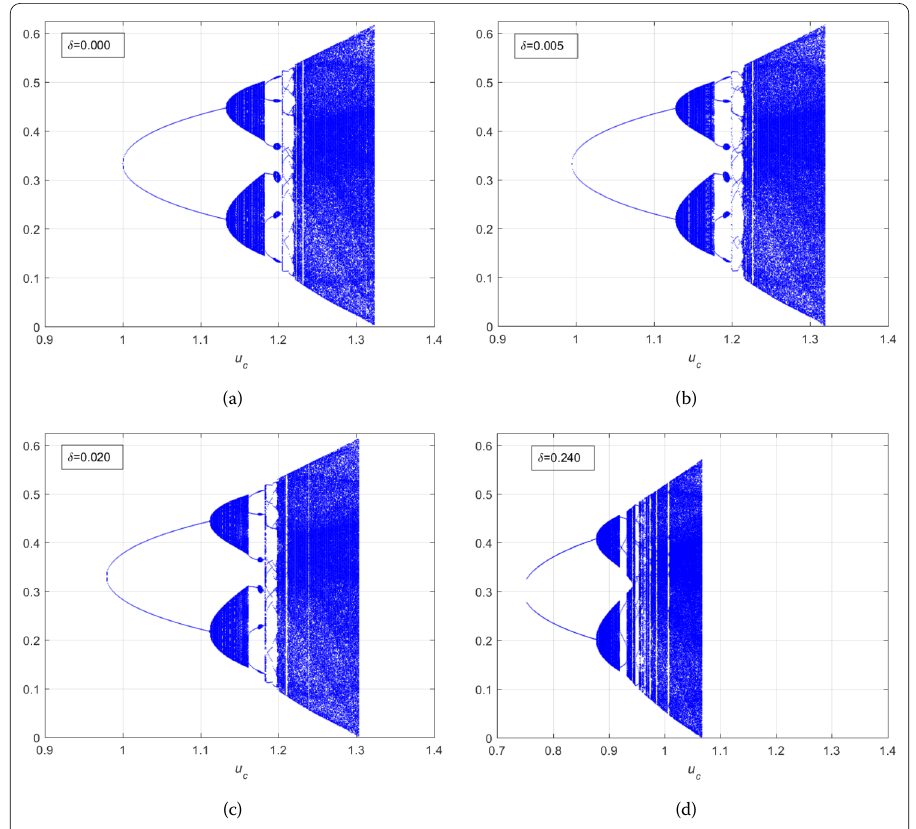
Figure 1 The bifurcation diagrams of deterministic and coupling stochastic logistic system